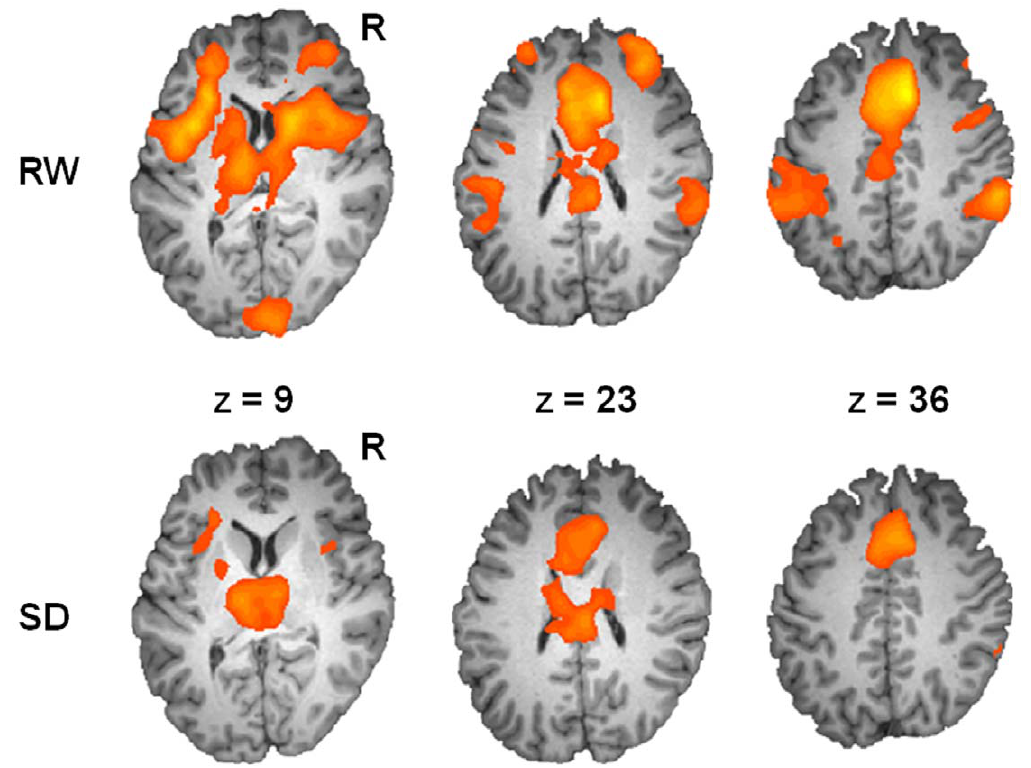
Figure 2. Effect of selective attention task on brain activation. Brain regions showing significant activation in the conjunction of Attend House (AH) vs. baseline and Attend Face (AF) vs. baseline conditions ( p , .001, uncorrected). The top panel depicts activation during rested wakefulness (RW), and the bottom panel depicts activation after approximately 24 h of total sleep deprivation (SD).